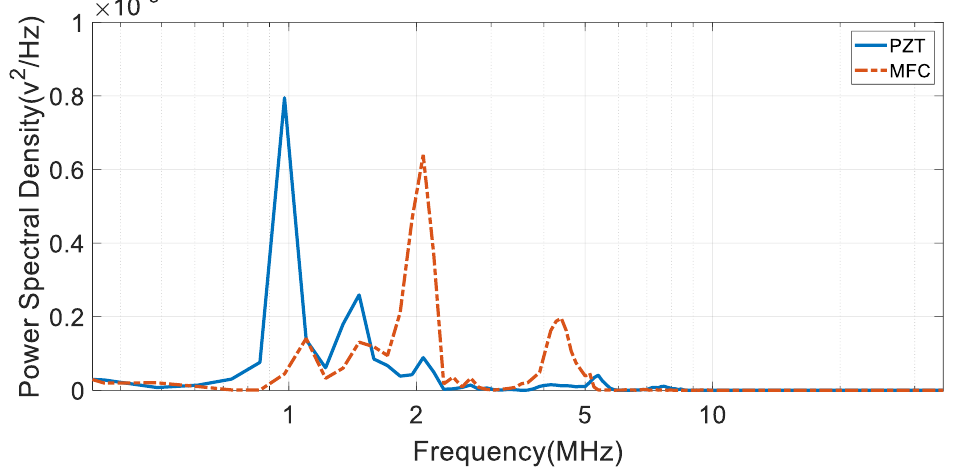
Figure 10. Power spectral density of the signals captured by AE sensors.